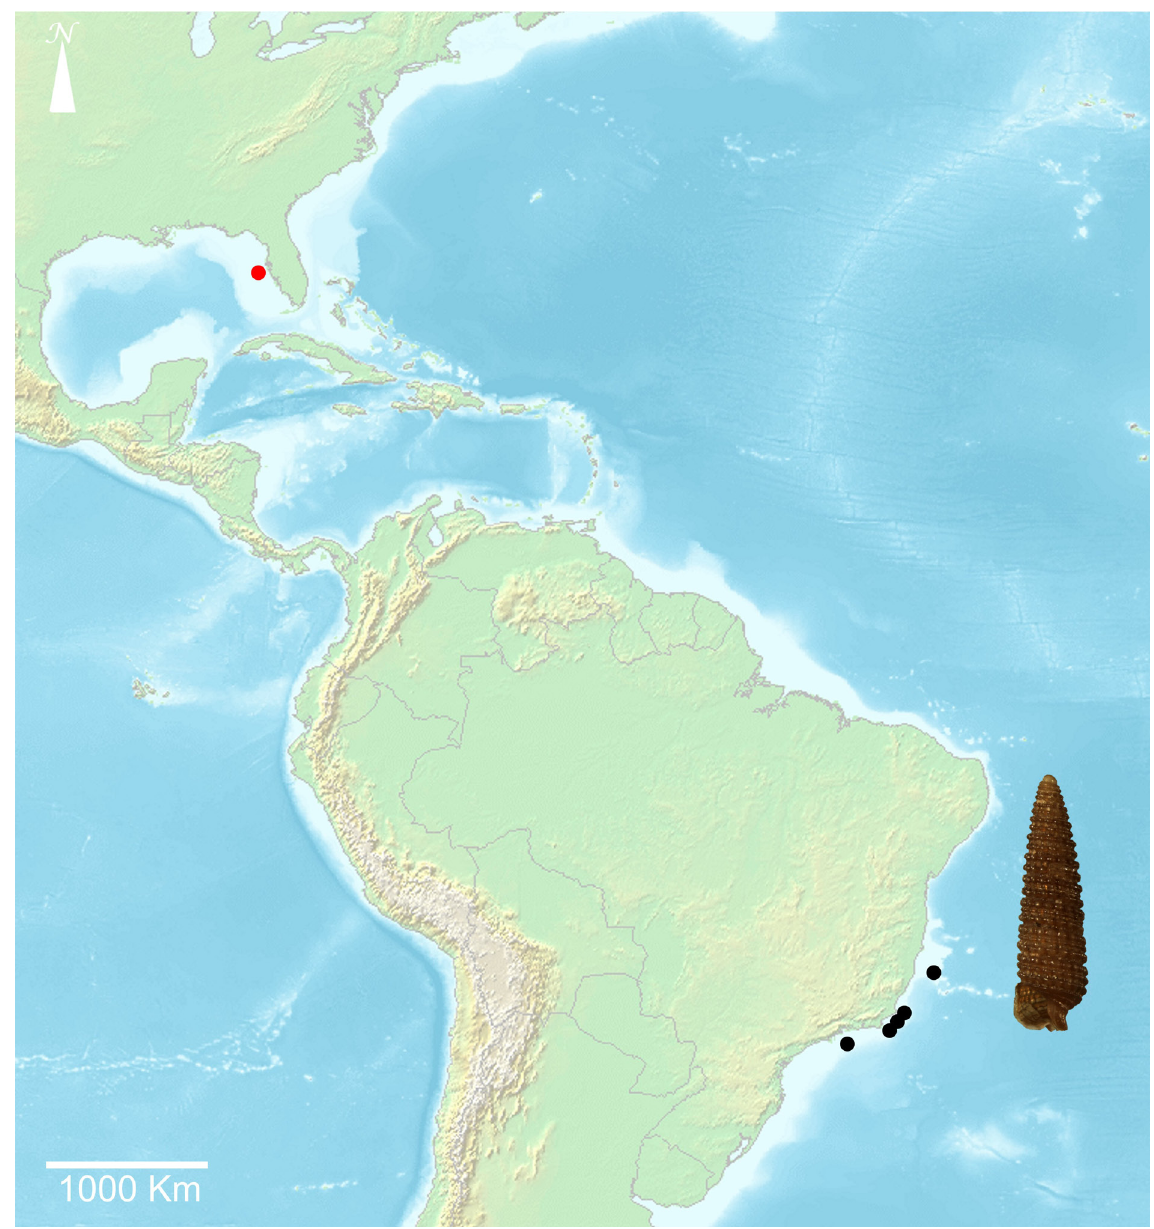
Fig. 36. Distribution map of “ Inella ” differens Rolán & Lee, 2008; red circle = type